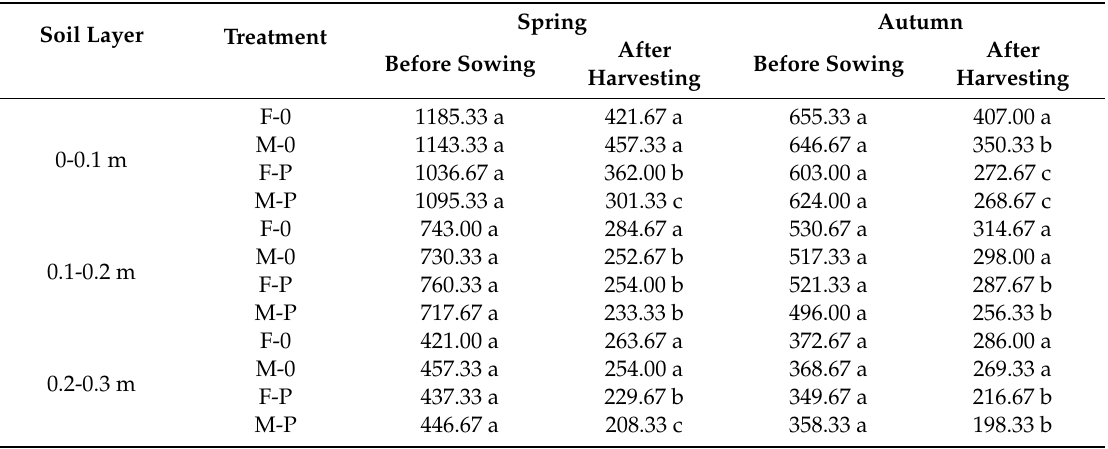
Table 4. The EC values ( µ S cm − 1 ) in soil before sowing and after harvesting in top soil layers